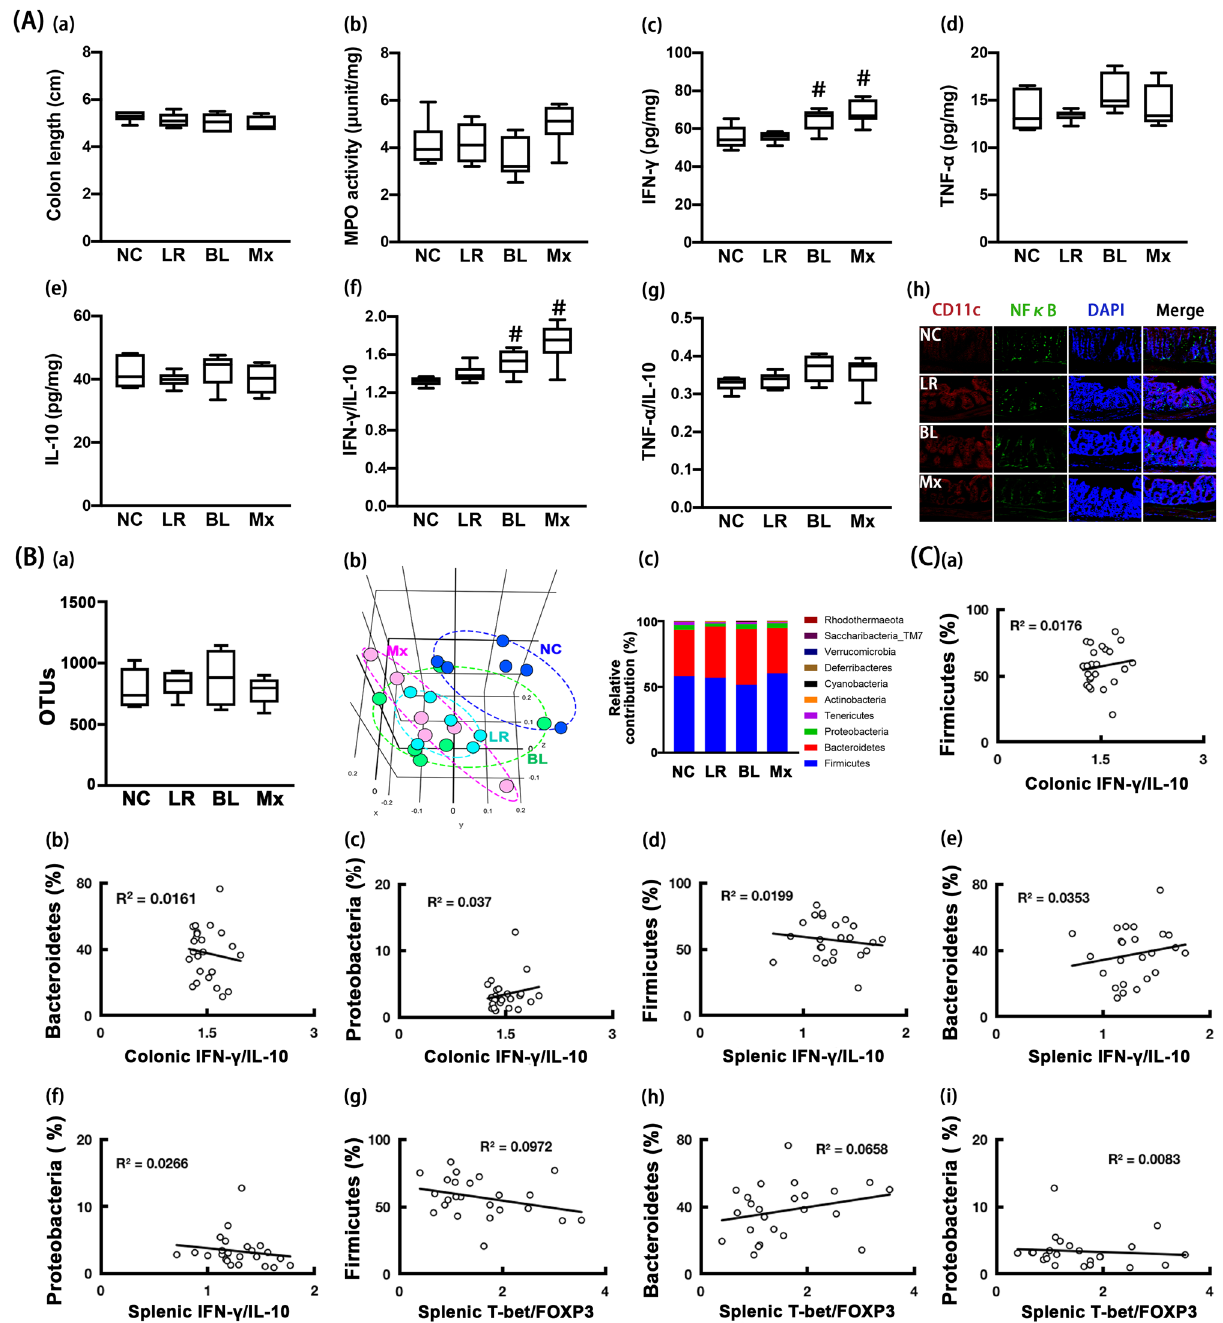
Figure 8. Effects of NK210 and NK219 on gut immune response and microbiota composition in mice. ( A ) Effects on colitis: colon length (a), myeloperoxidase (MPO) activity (b), IFN-γ (c), TNF-α (d), IL-10 expression (e), IFN-γ to IL-10 expression ratio (f), TNF-α to IL-10 expression ratio (g), and NF-κB + /CD11c + cell population in the colon (h). ( B ) Effects on the gut microbiota composition: (a) α-diversity (OUT richness, a), (b) β-diversity (PCoA plot based on Jensen-Shannon analysis), and (c) gut microbiota composition at the phylum level. The correlation between gut microbiota and IFN-γ to IL-10 or Tbet to Foxp3 expression ratio at the phylum ( C ) and family levels ( D ). NK210 (LR, 1 × 10 9 CFU/mouse/day), NK210 (BL, 1 × 10 9 CFU/mouse/day) or their mix (Mx, 1 × 10 9 CFU/mouse/day of LR and BL [4:1] mix) were orally gavaged daily for 5 days. Normal control mice (NC) were treated with vehicle (saline) instead of test agents. Data values indicate mean ± SD (n = 8). # p < 0.05 versus NC